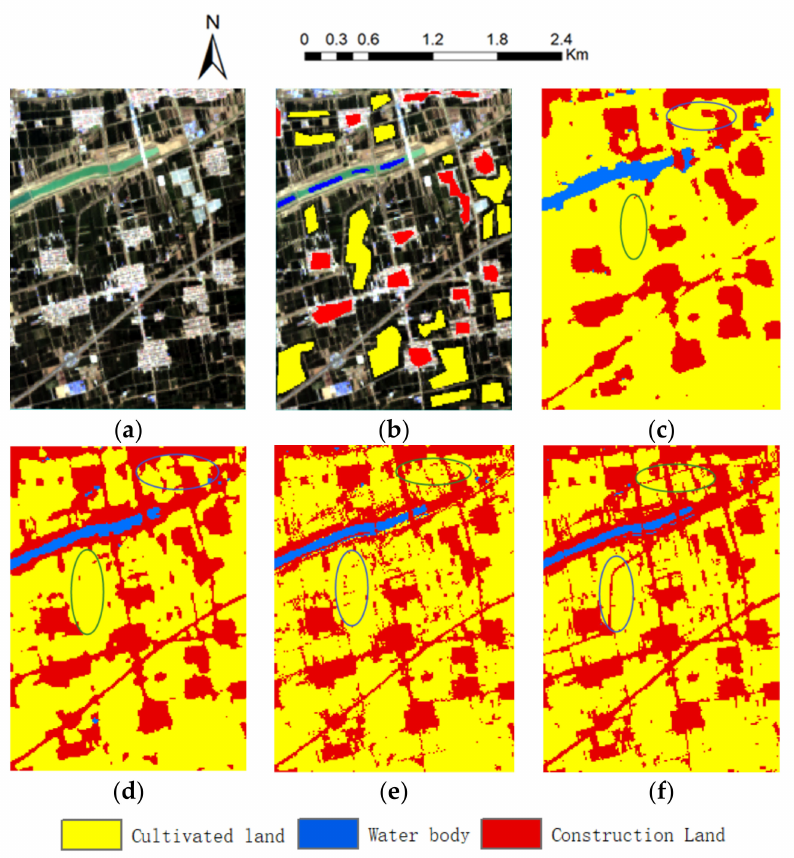
Figure 5. Classification maps of typical region. ( a ) True Color Image; ( b ) Land use ground truth; ( c ) 2D-CNN; ( d ) HybridSN; ( e ) SVM; ( f )